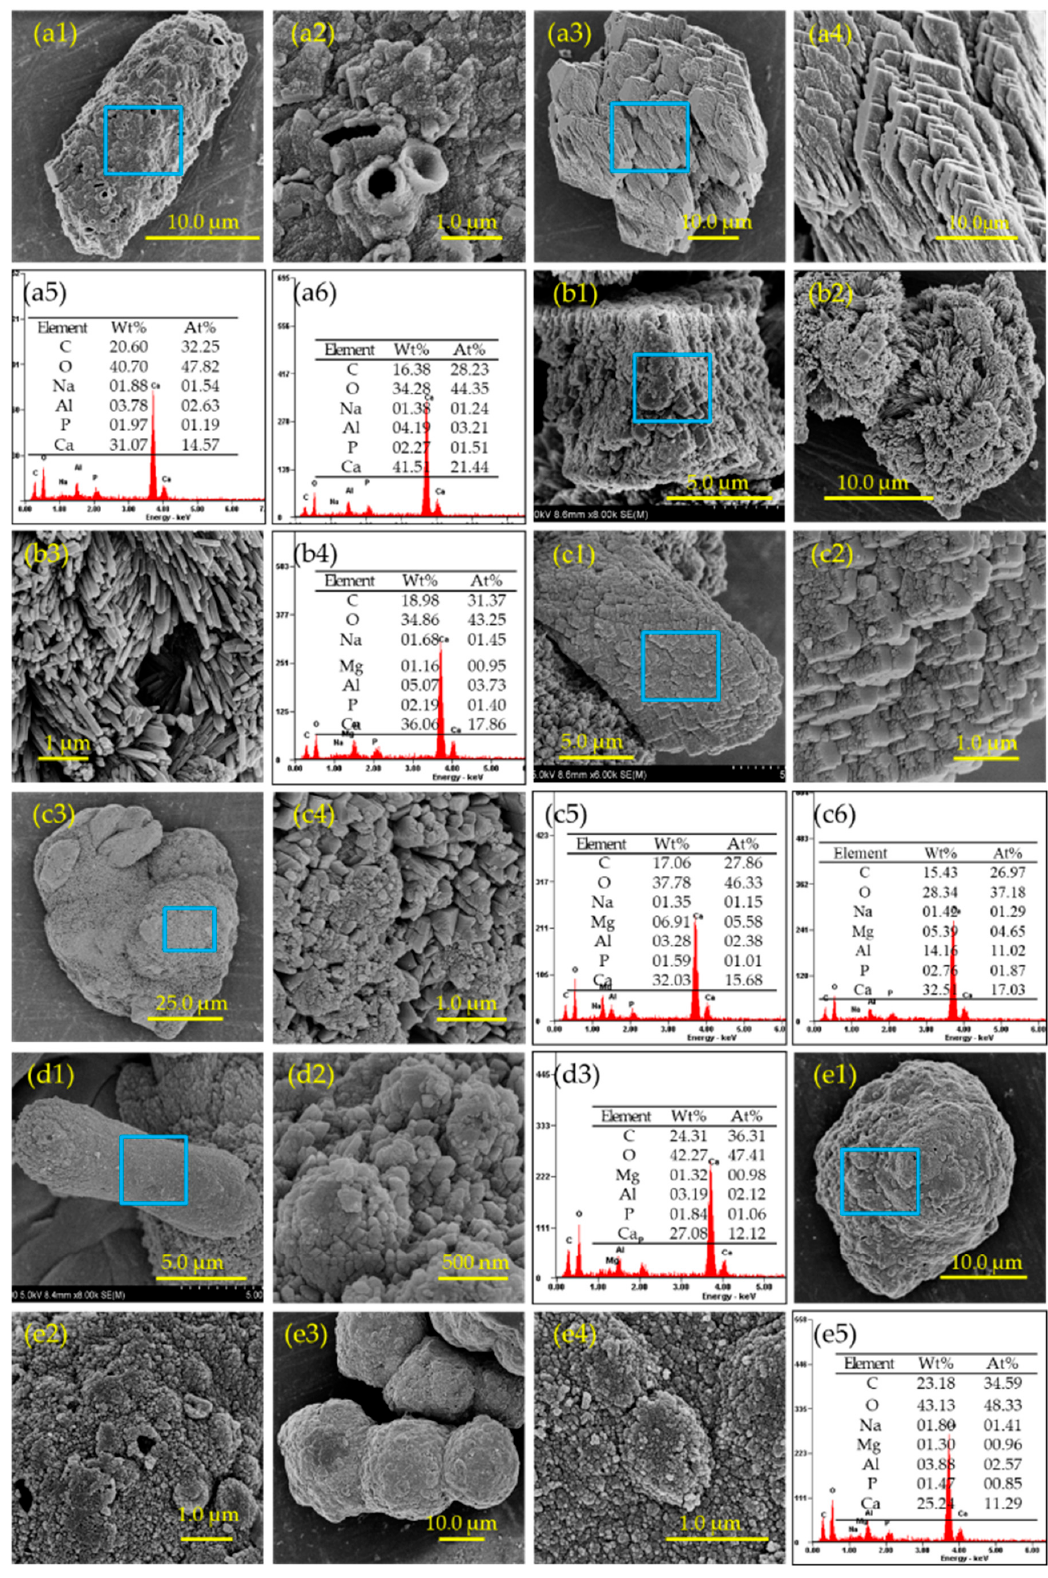
Figure 3. Scanning electron microscope (SEM) images and energy dispersive spectra (EDS) of minerals at di ff erent Mg / Ca ratios. a1–a4 , b1–b3 , c1–c4 , d1–d2 , and e1–e4 : morphologies of minerals at Mg / Ca molar ratios of 0, 2, 4, 6 and 8, respectively. a5, a6, b4, c5, c6, d3, and e5: EDS analyses of minerals marked by blue square in a1, a3, b1, c1, c3, d1, and e1,